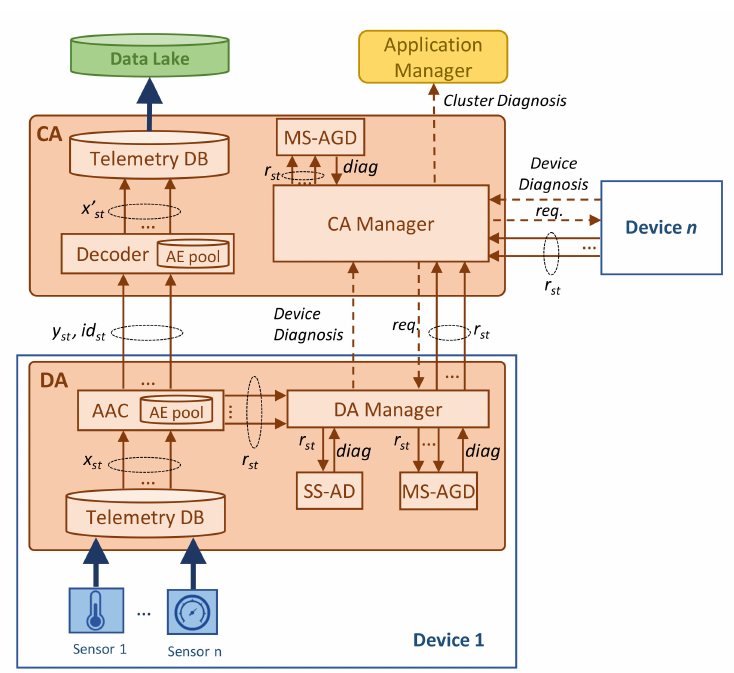
Figure 2. Detailed architecture and key